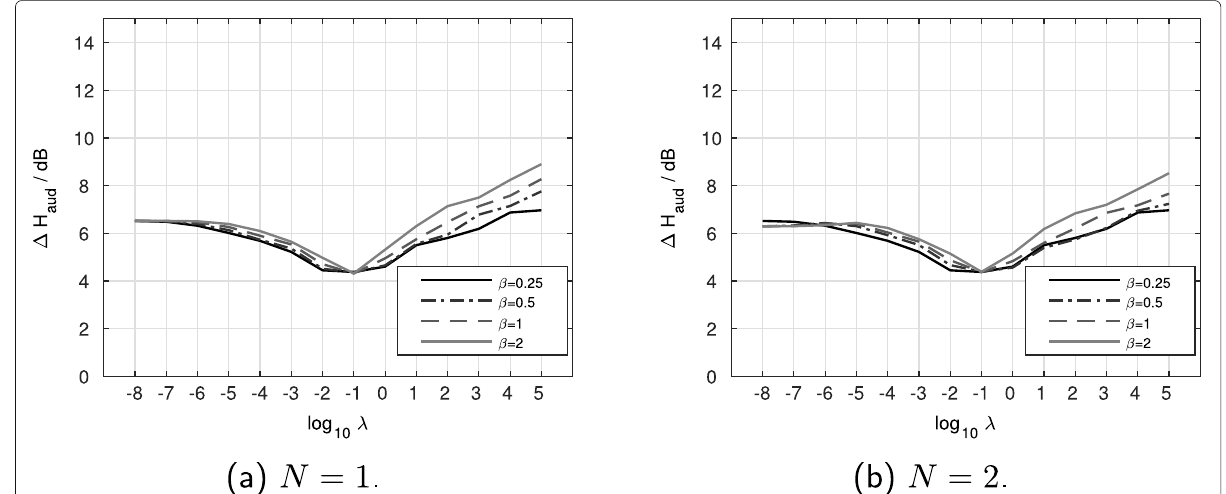
Fig. 7 Auditory spectral distance as a function of the regularization parameter λ for different values of control parameter β for a N = 1 loudspeaker and b N = 2 loudspeakers ( d H = 32, G 0 = 0dB, d G = 96)